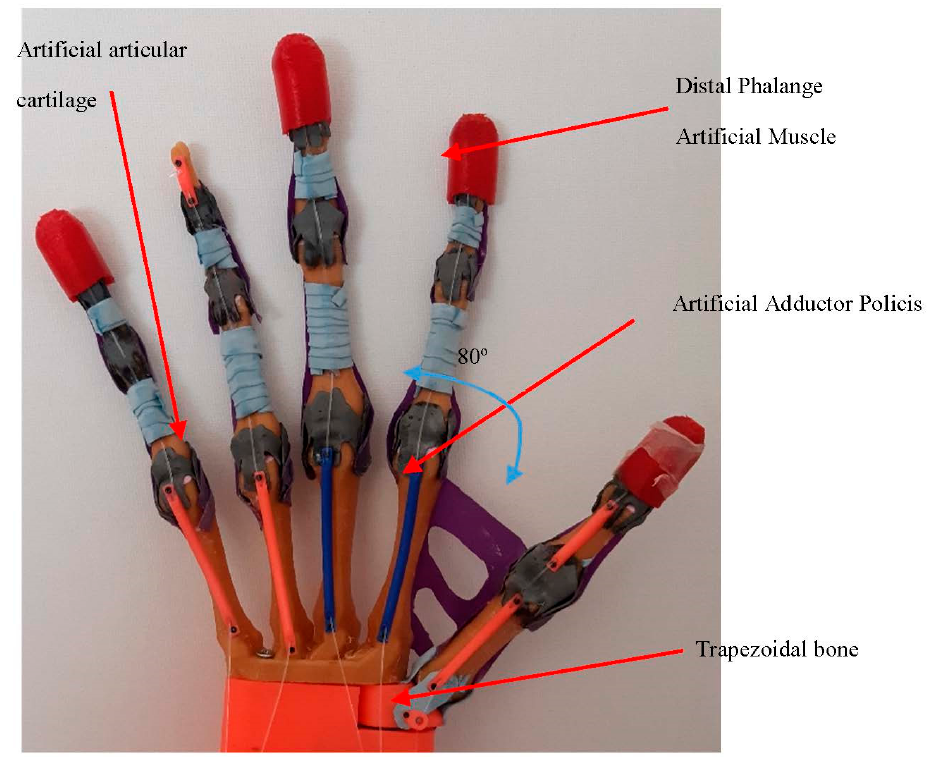
Figure 5. Mechanical assembly of the prosthetic hand.